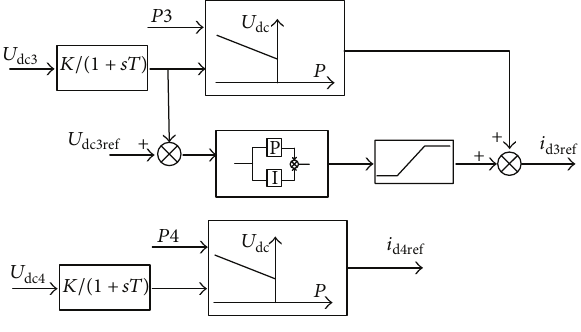
Figure 5: Design of the priority